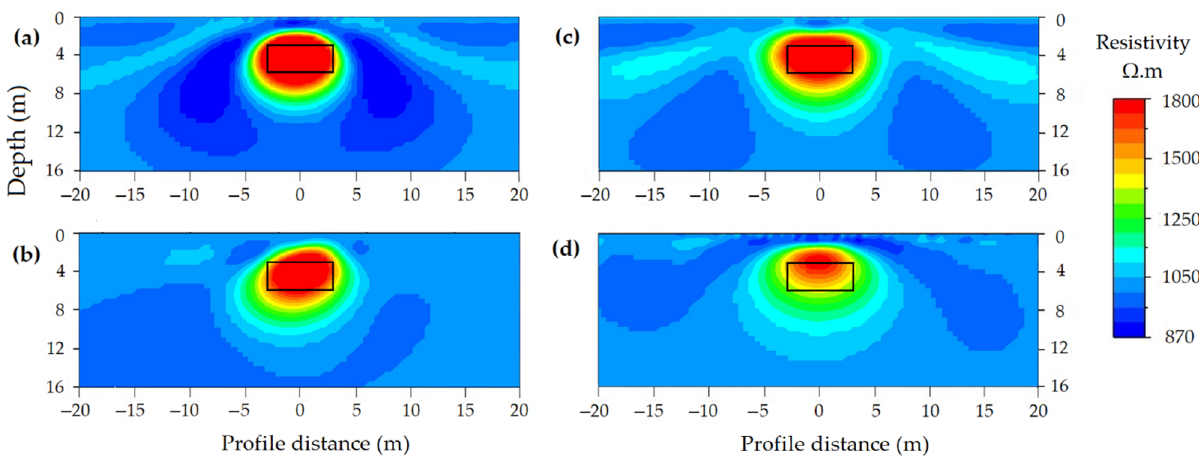
Figure 15. The inverted resistivity model for scenario 3 with 3 × 6 m cavity size using: ( a ) DD array, ( b ) PD array, ( c ) WS array, ( d ) PP array. The rectangular box indicates the actual cavity target.